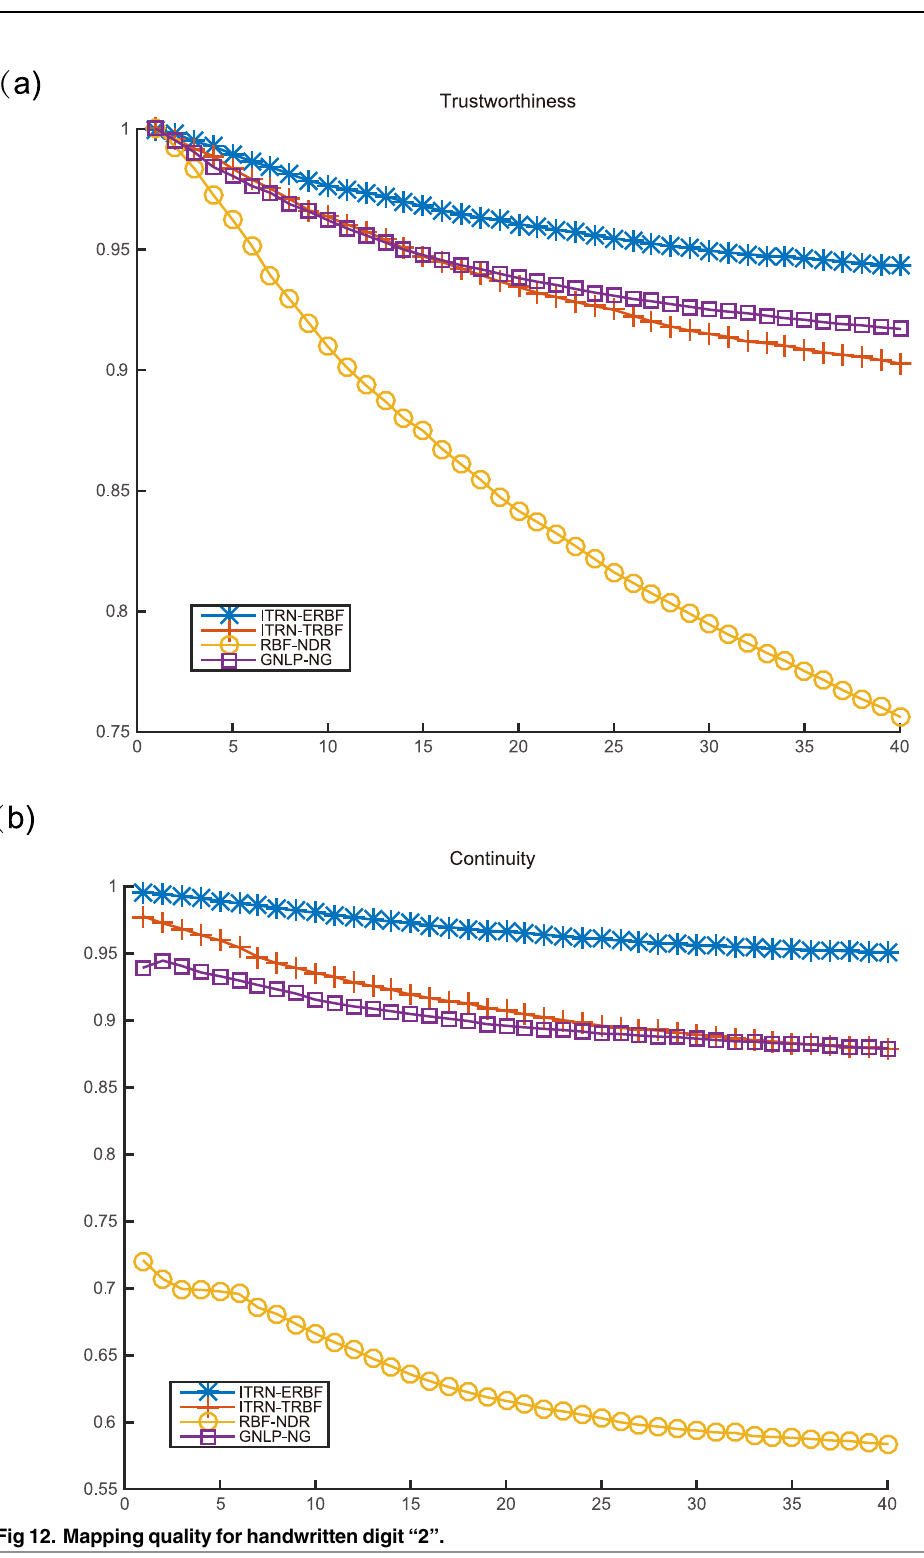
PLOS ONE | DOI:10.1371/journal.pone.0131631 July 10,